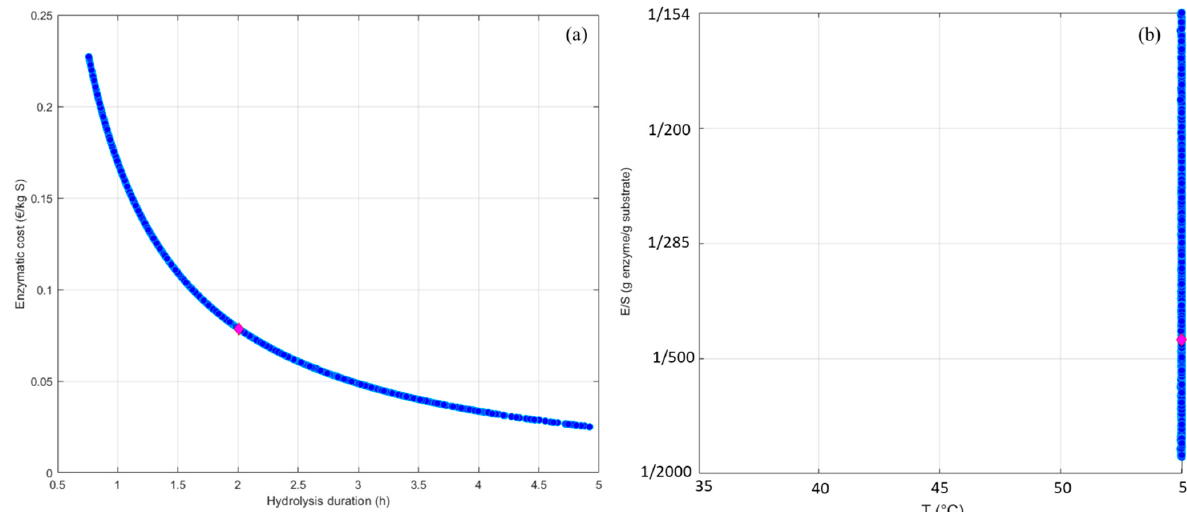
Figure 6. Identification of the Pareto’s front ( a ) and the Pareto’s domain ( b ), (blue points) and selection of the best duration/enzymatic cost trade-off (pink diamond) in the case of the applied study. Enzymatic cost is expressed in € per amount of protein (kg substrate).